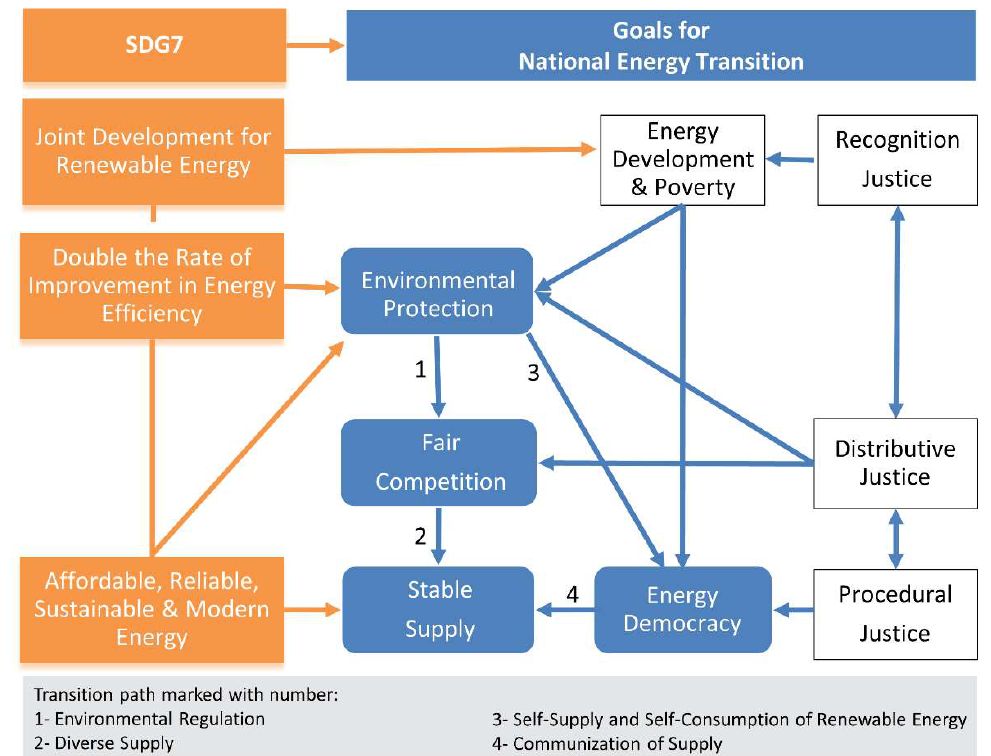
Figure 2. Response to Sustainable Development Goals (SDGs) with the national energy transition framework and path.